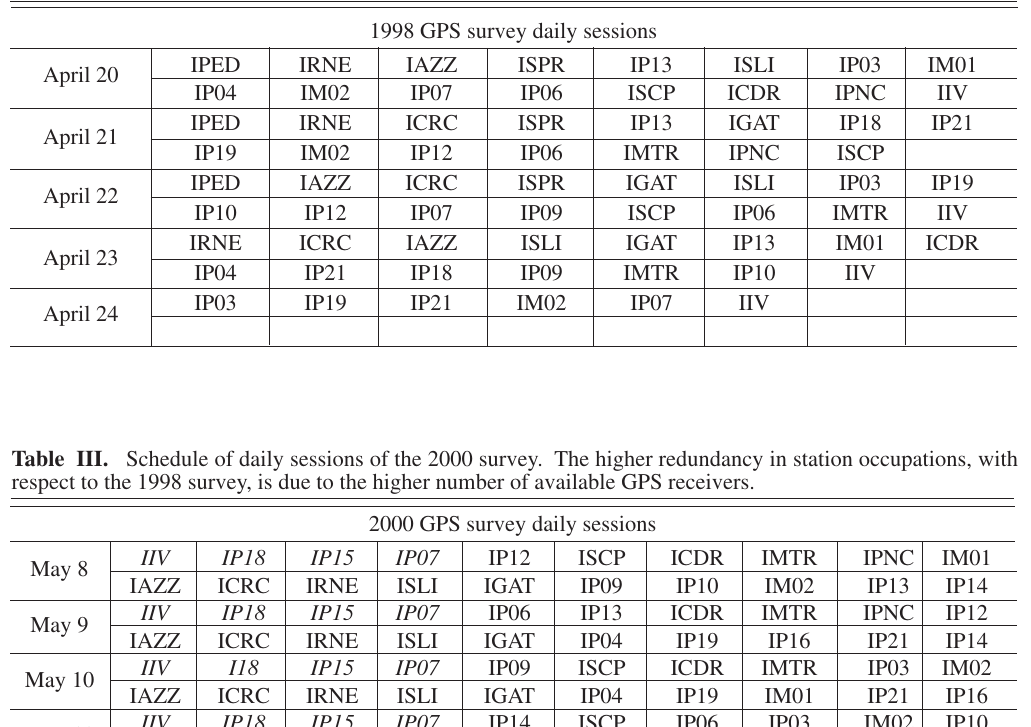
Table II. Schedule of daily sessions of the 1998 survey. 1998 GPS survey daily sessions